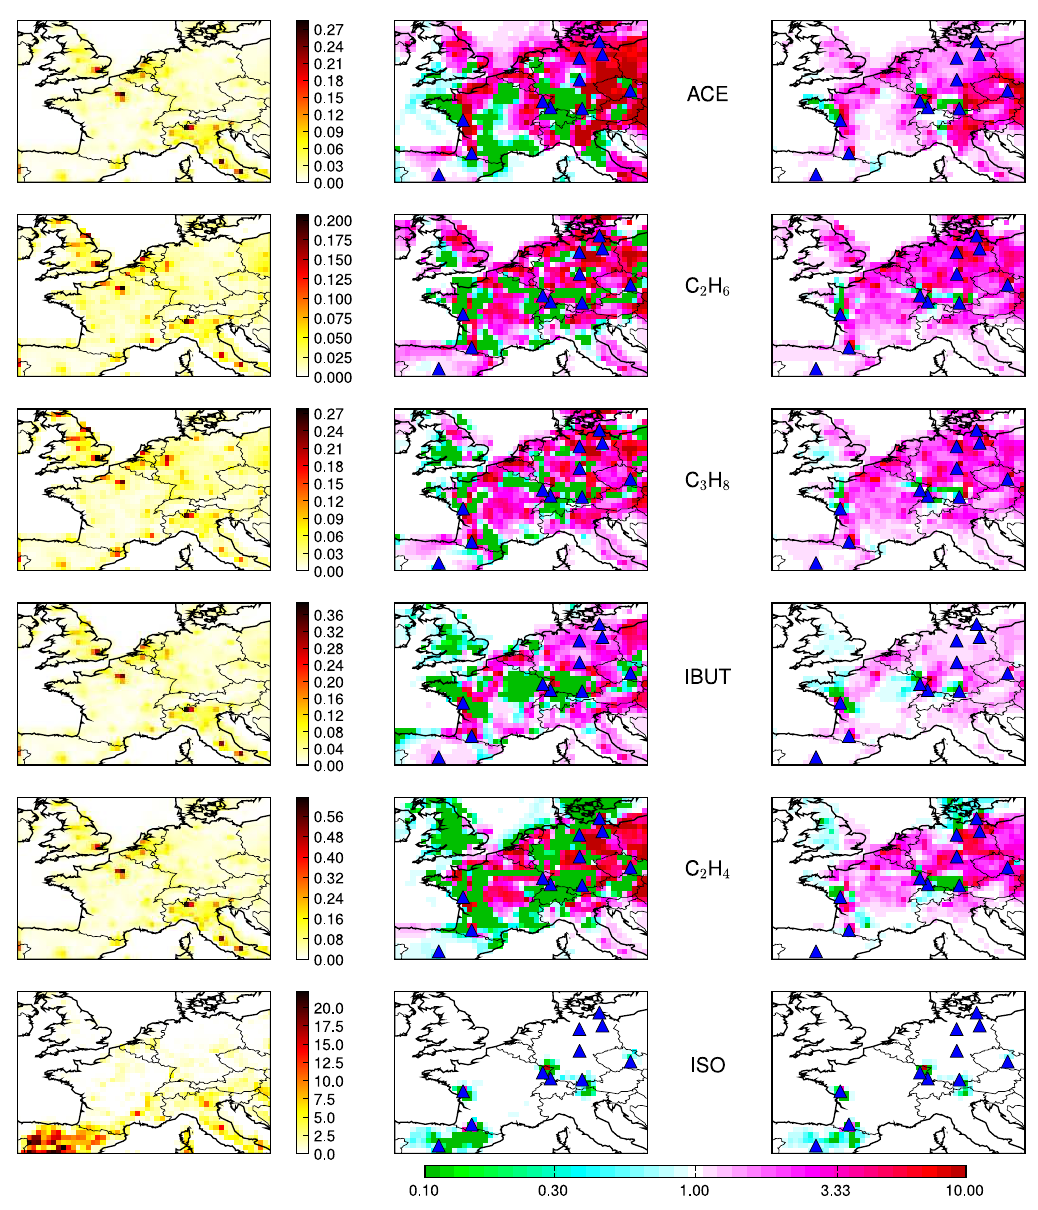
Fig. 6. Gridded EMEP time-integrated flux (in tkm − 2 yr − 1 , left column) and gridded ratios of time-integrated retrieved flux to EMEP time- integrated flux for, from top to bottom, acetylene (ACE), ethane (C 2 H 6 ), propane (C 3 H 8 ), isobutane (IBUT), ethylene (C 2 H 4 ) and isoprene (ISO). The species are ordered by decreasing lifetime. The central column corresponds to case B2 and the right column corresponds to case C. Green and blue colours correspond to reduction of the emission fluxes, whereas red and pink colours correspond to an increase of the emission fluxes.